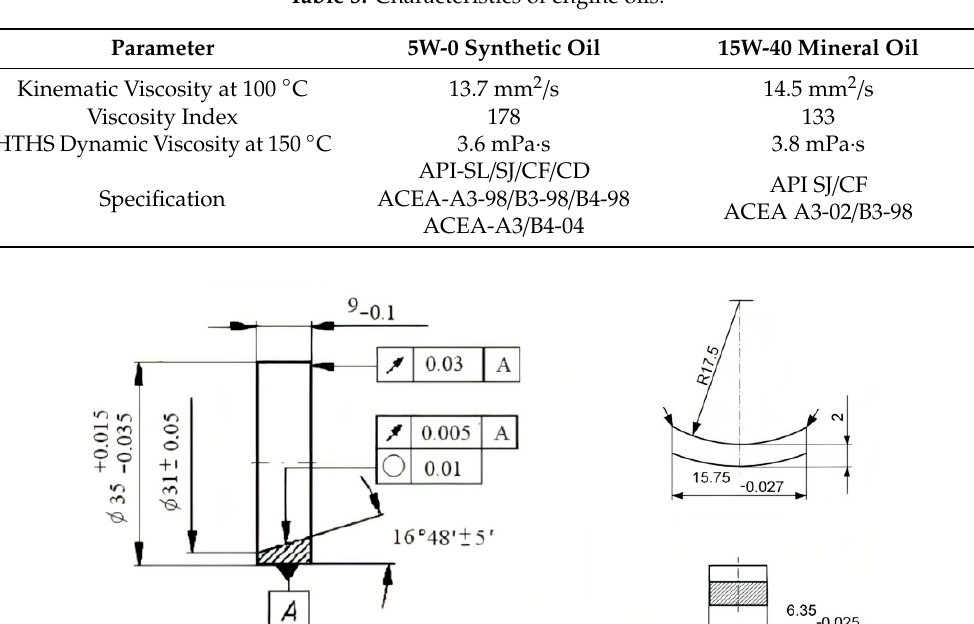
Table 3. Characteristics of engine oils.